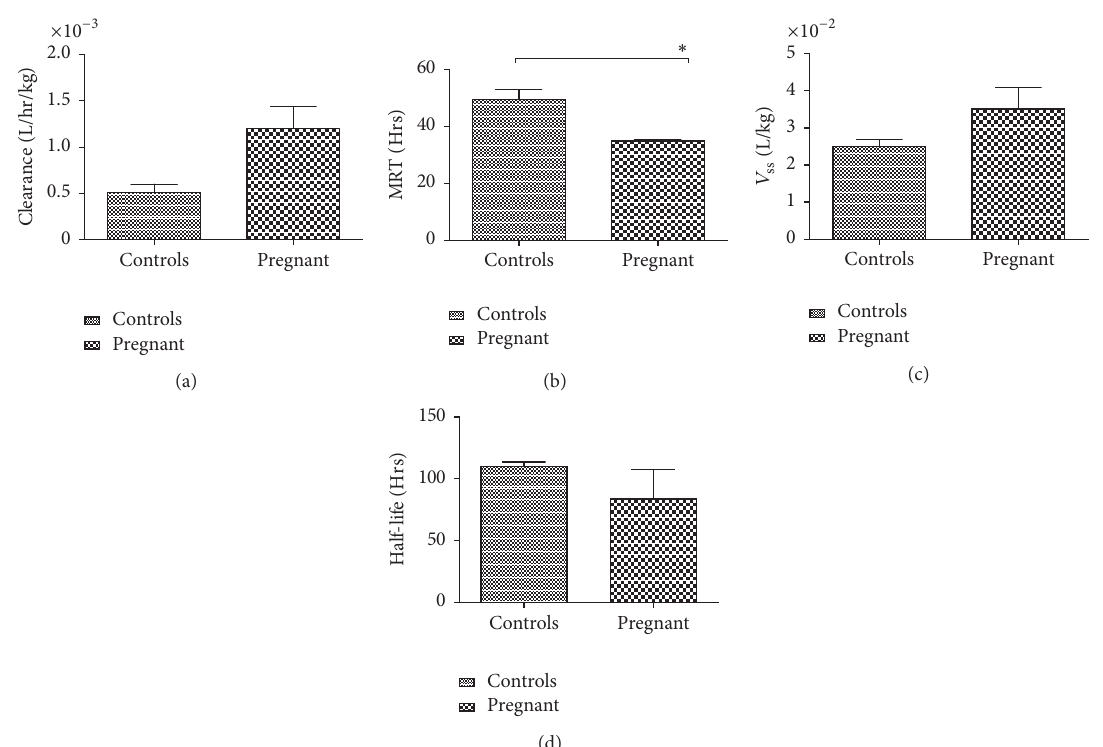
Figure 2: Pharmacokinetic (PK) parameters of a hepatitis B immune globulin (HBIG) product in pregnant and nonpregnant guinea pigs. Human IgG has larger clearance (a), lower mean residence time (MRT, (b)), larger volume of distribution at steady state ( 𝑉 ss , (c)), and lower half-life (d) when it is administered at the end of gestation (GD 65 ± 2 ) compared to nonpregnant animals; data shown as mean ± SEM , ∗ 𝑝 < 0.05 (Student’s t